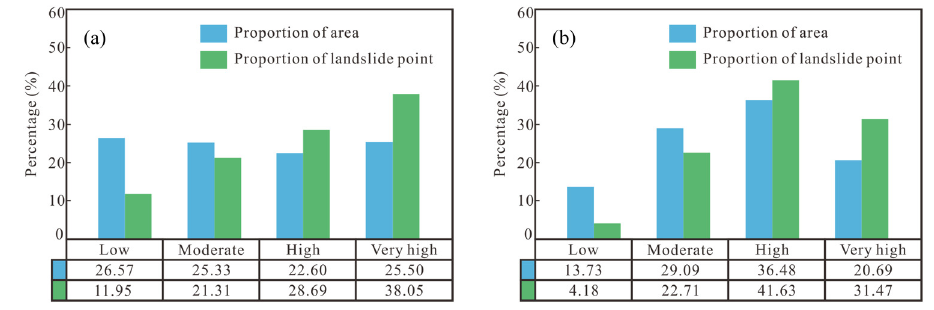
Figure 6: Raster distributions of landslides within di ff erent classes. ( a ) FR, and ( b )